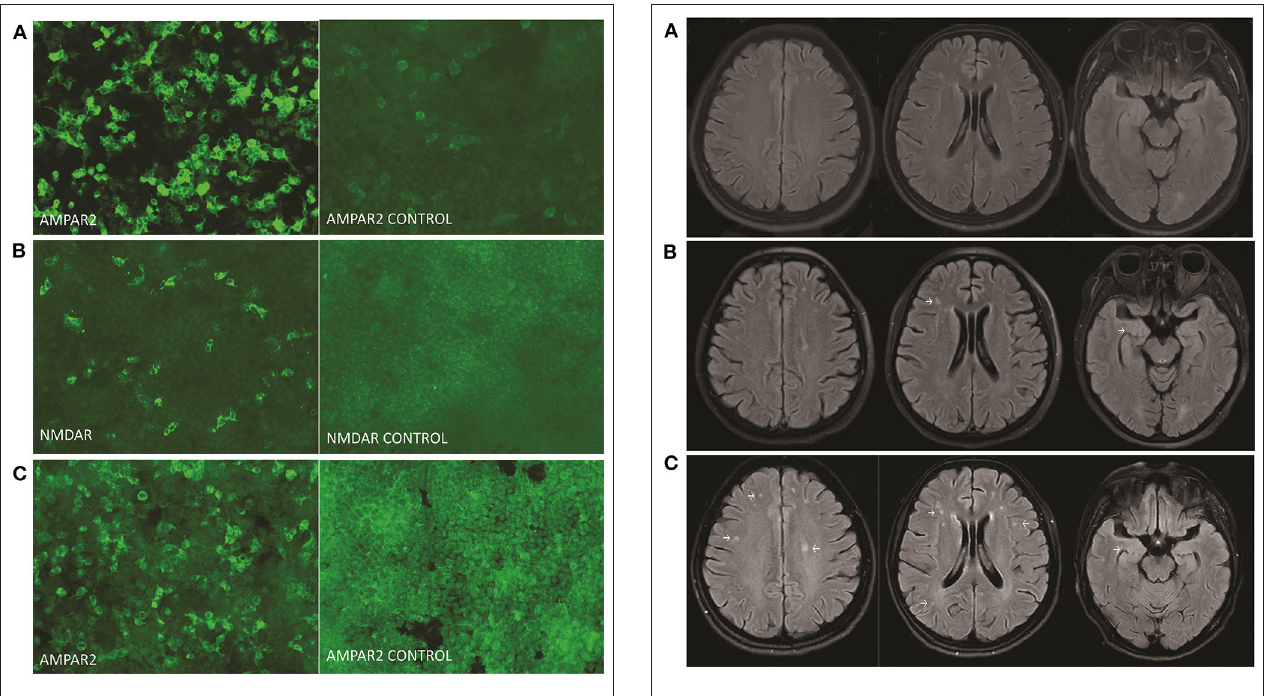
FIGURE 2 | Presence of autoimmune antibodies in serum and CSF. Immunoactivity of the anti-AMPA-receptor 2 antibody (A) , anti-NMDA-receptor antibody (B) in cerebrospinal fluid, and anti-AMPA-receptor 2 antibody in serum (C) at 9 days after onset. The titer of antibodies in the cerebrospinal fluid and serum were measured as 1:32 (original magnification, 200 × ).